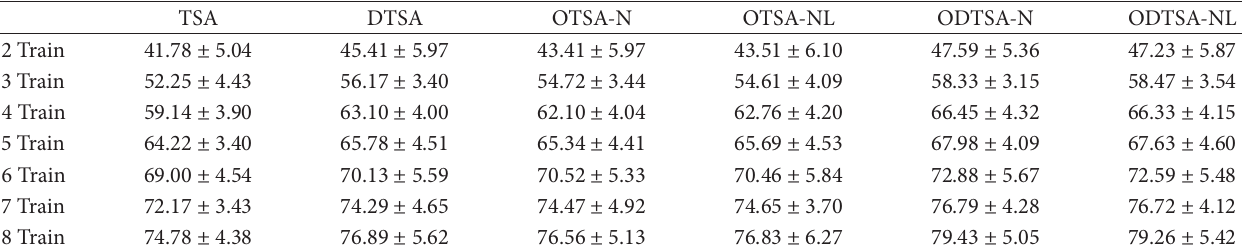
Table 4: Recognition accuracy ( % ) on Yale database (mean ± std).